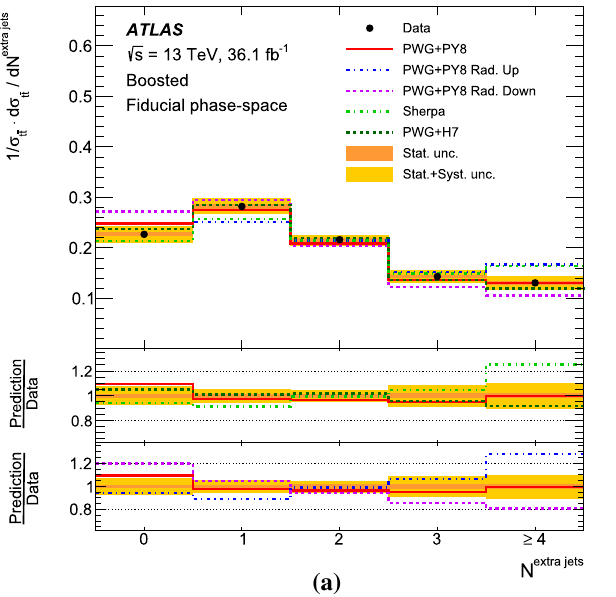
( a ) (b) Fig. 42 Particle-level normalised differential cross-sections as a func- the statistical and total uncertainty in the data. Data points are placed at the centre of each bin. The lower panel shows the ratios of the simula- tion of a the number of additional jets and b the number of small- R jets tions to data composingthehadronicallydecayingtopquarkintheboostedtopology, compared with different Monte Carlo predictions. The bands represent